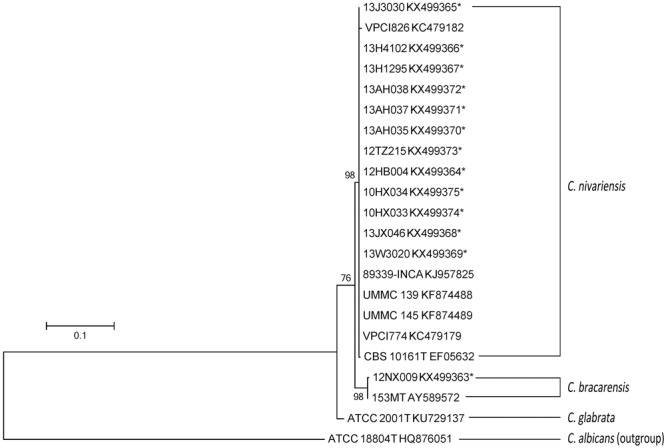
The maximum-likelihood tree of C. nivariensis and C. bracarensis with D1/D2 sequences available in GenBank, using Candida albicans ATCC 18804 as an outgroup.